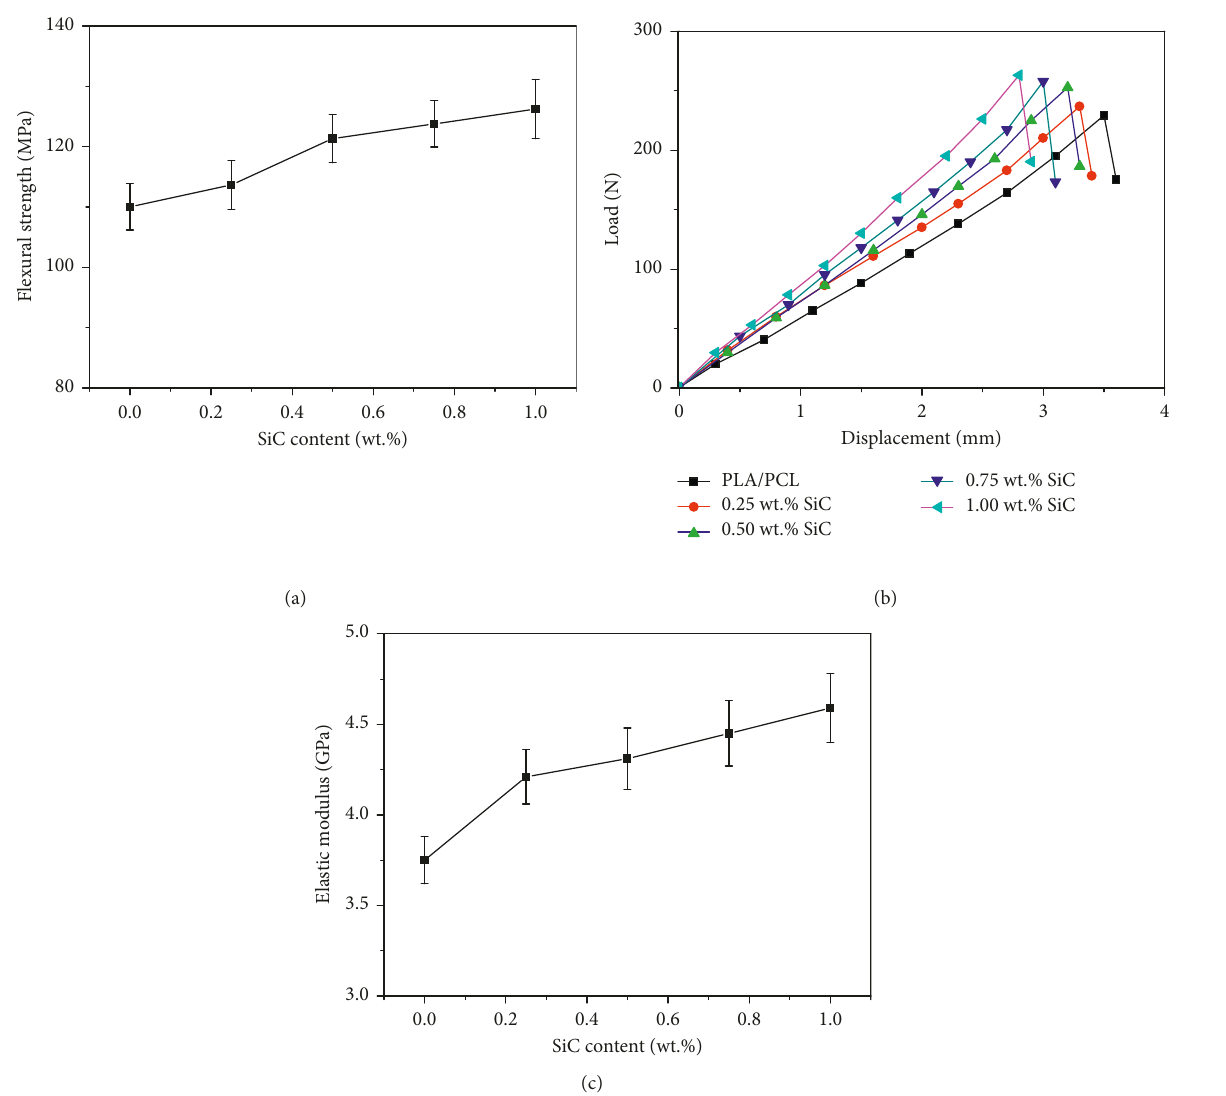
Figure 4: Flexural strength (a), load (b), and elastic modulus (c) of PLA/PCL/SiC